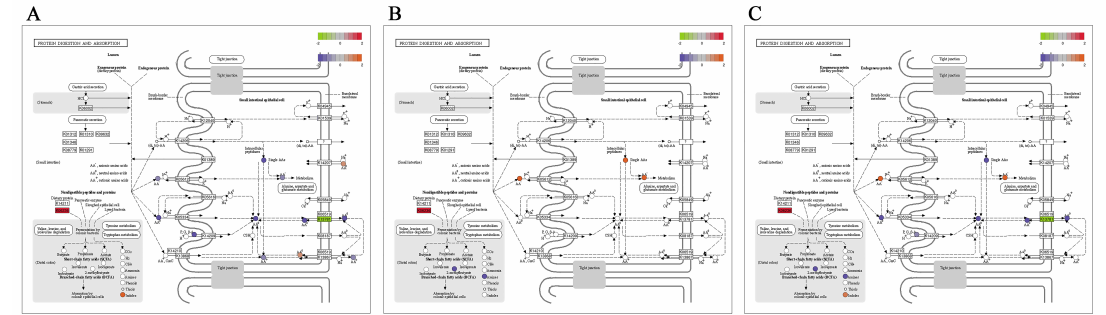
Figure 11. The pathway of protein digestion and absorption. ( A ) E15_BM vs. E21_BM; ( B ) E21_BM